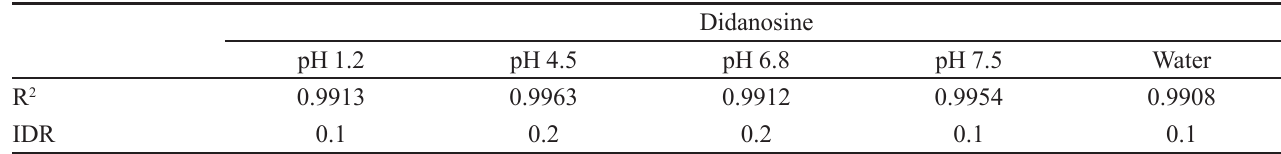
TABLE II - Intrinsic dissolution rate (IDR) (mg/min/cm 2 ) for ddI